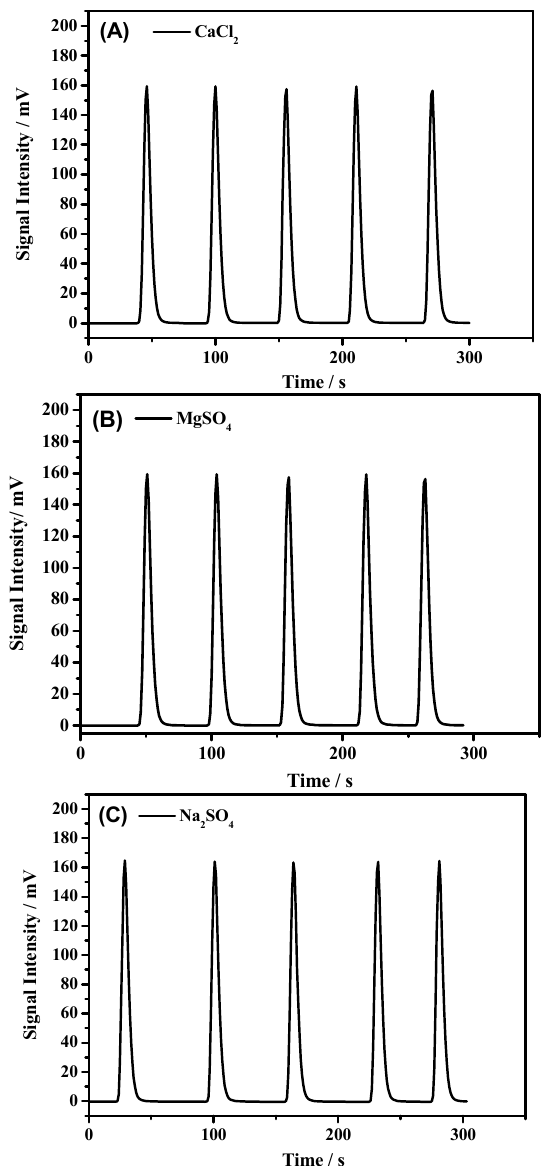
Figure 3. Adsorption performance of desiccants on C 4 F 7 N tested with pulse adsorption, ( A ) CaCl 2 , ( B )